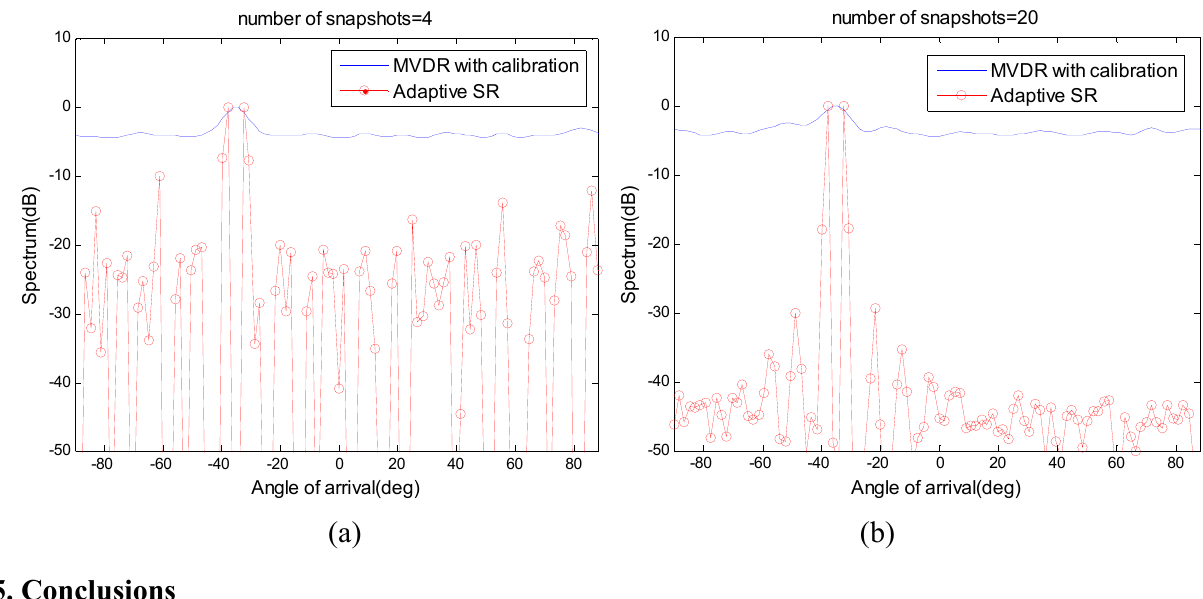
Figure 5. (a) Spectrum estimation result with L = 4 snapshots. (b) Spectrum estimation result with L = 20